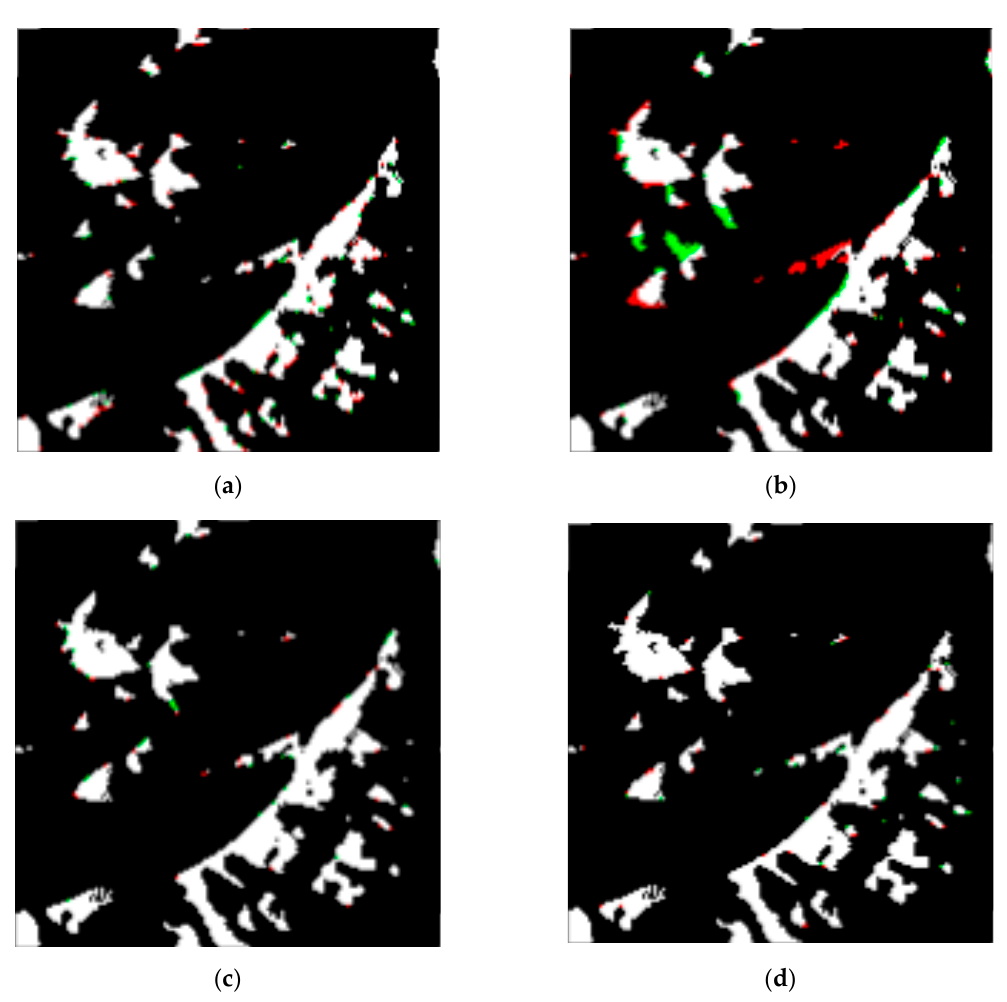
Figure 10. Partial viewsheds of different algorithms corresponding to the red rectangle in Figure 9. These viewsheds are generated by ( a ) R2, ( b ) XDraw, ( c ) 10-BT and ( d ) HiXDraw, respectively. Red means visible areas are wrongly determined as invisible and green means invisible areas are wrongly determined as visible.